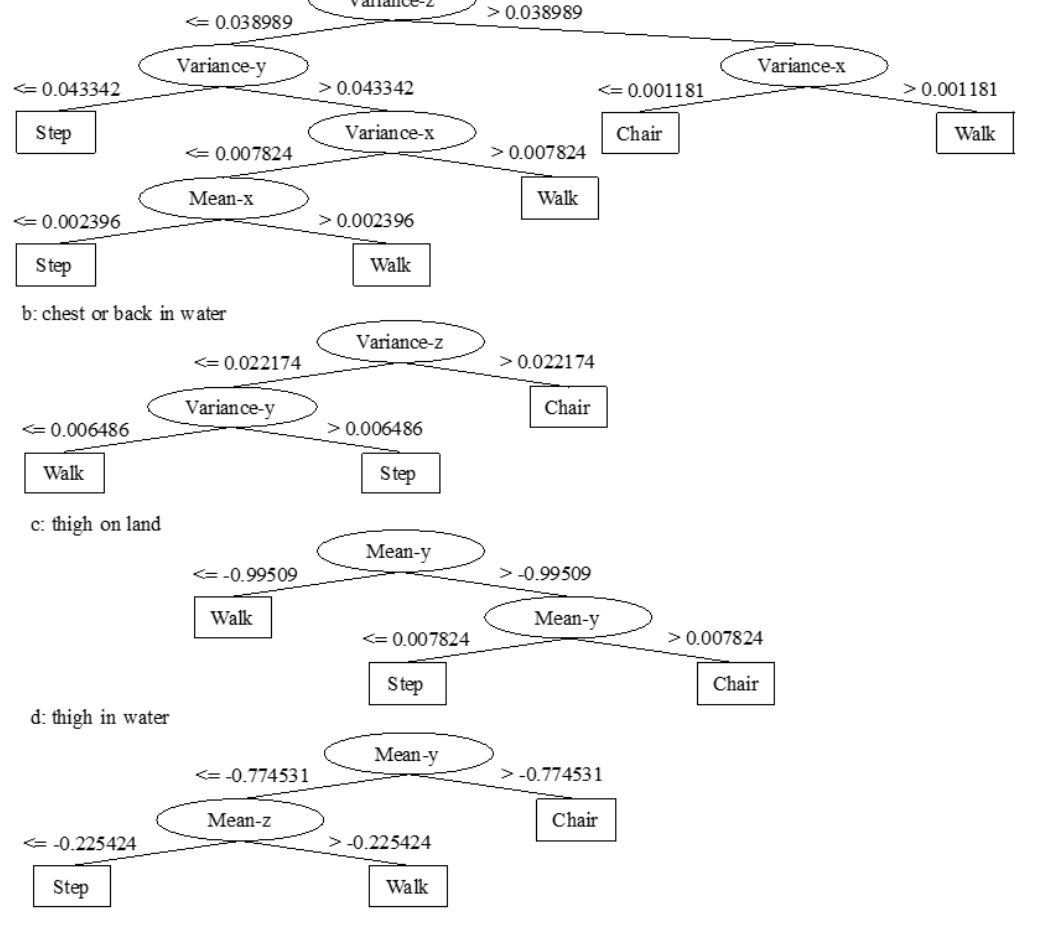
Figure 4. Decision tree structures of each sensor position and condition. a: chest or back on land, b: chest or back in water, c: thigh on land, d: thigh in